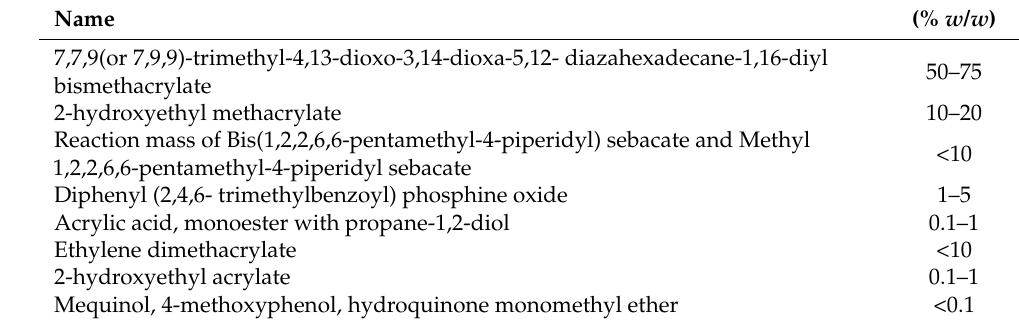
Table 1. Chemical composition of the reference material—Dental LT Clear